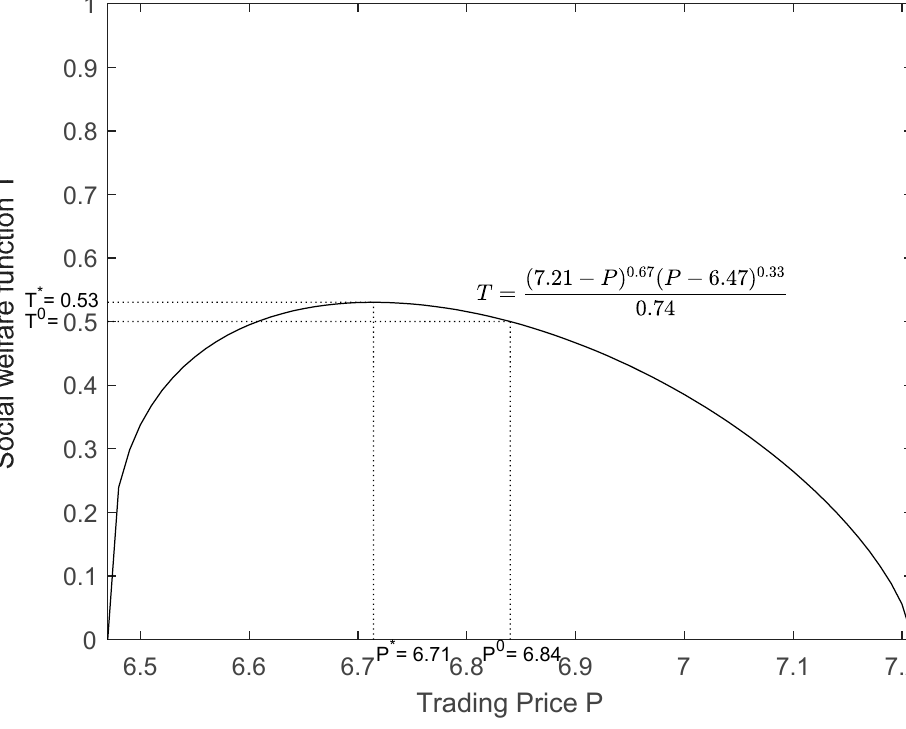
Figure 3. Schematic diagram of the optimal transaction price.